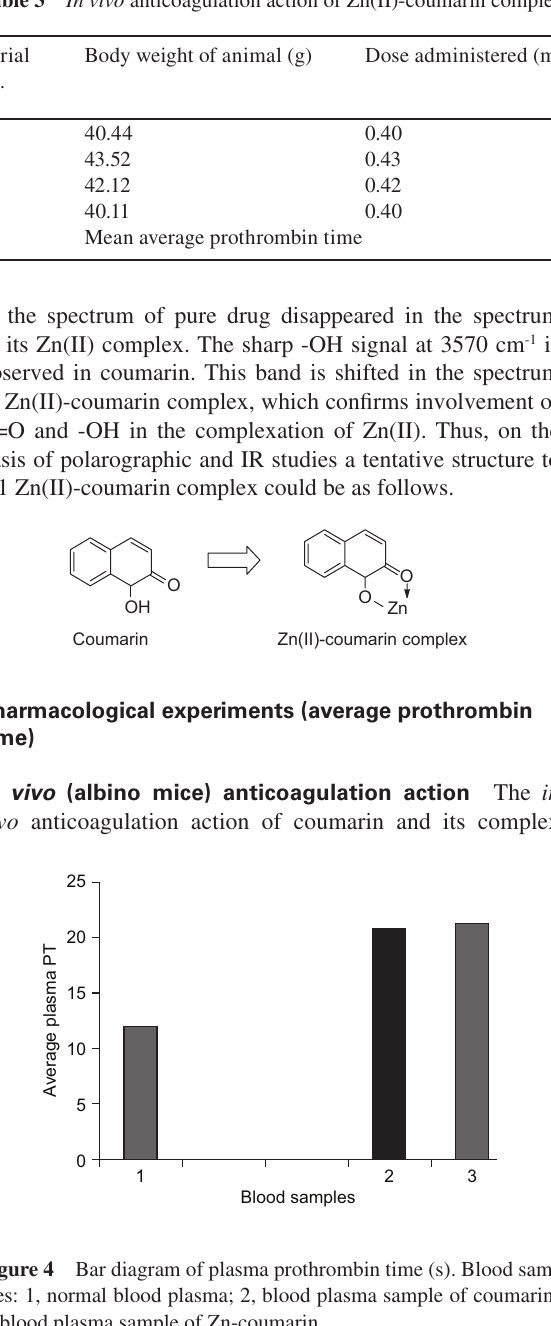
Table 3 In vivo anticoagulation action of Zn(II)-coumarin complex in albino mice.